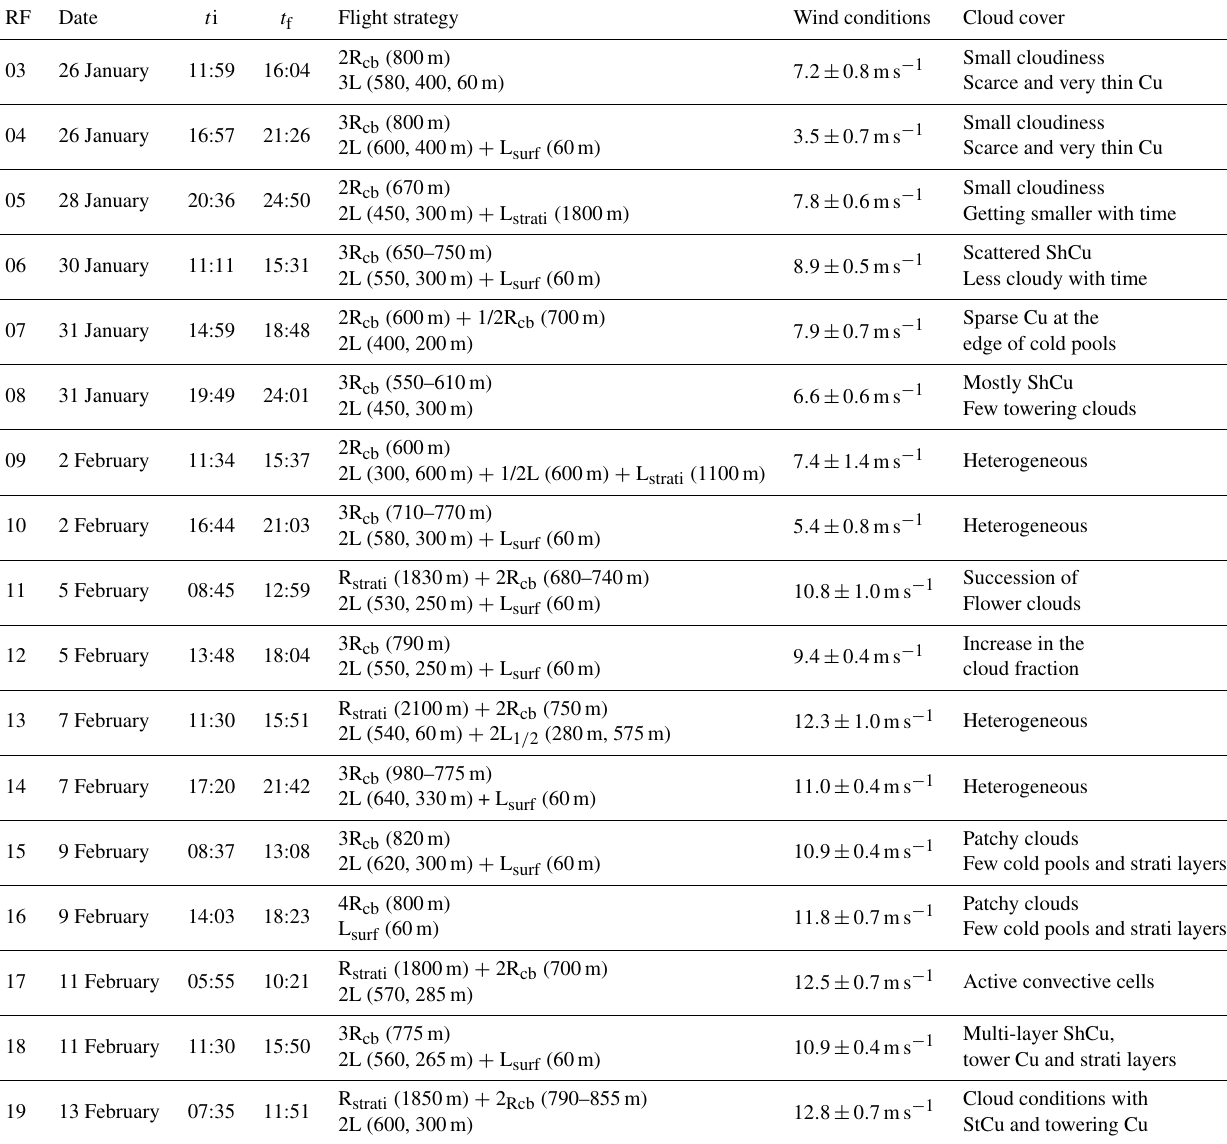
Table 1. Flight plan and wind conditions associated with each flight during the EUREC 4 A field campaign. The flight altitude is indicated be- tween brackets, and the notations “cb”, “strati” and “surf” refer to cloud base, stratiform layer and surface, respectively. The wind conditions within the subcloud layer are inferred from the averaged airborne measurements over the L legs, including both the top and mid-subcloud layer (except for RF16, during which there was no L pattern). t i and t f are UTC times for the start and end of the flights,